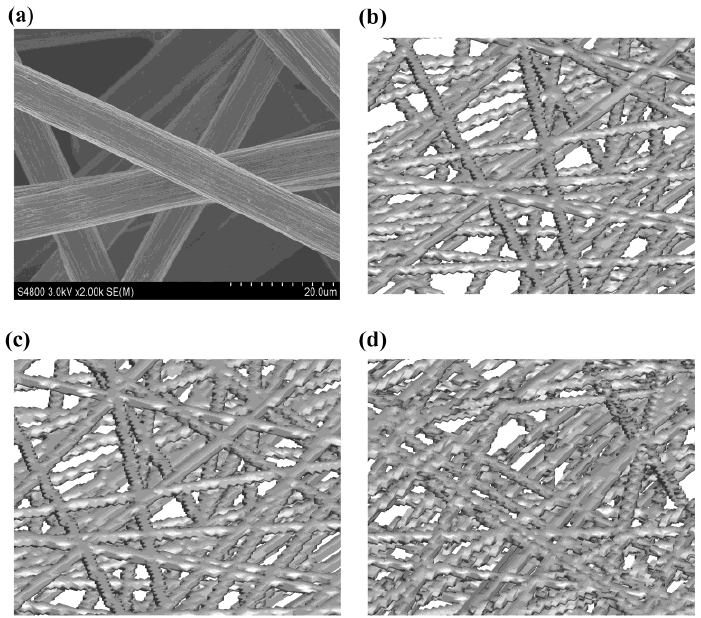
Figure 2. GDL carbon paper micrographs. ( a ) Toray (TGP-H-060) image; ( b ) 3D reconstructed 8 µm fiber diameter; ( c ) 3D reconstructed 9 µm fiber diameter; ( d ) 3D reconstructed non-uniform fiber diameter.